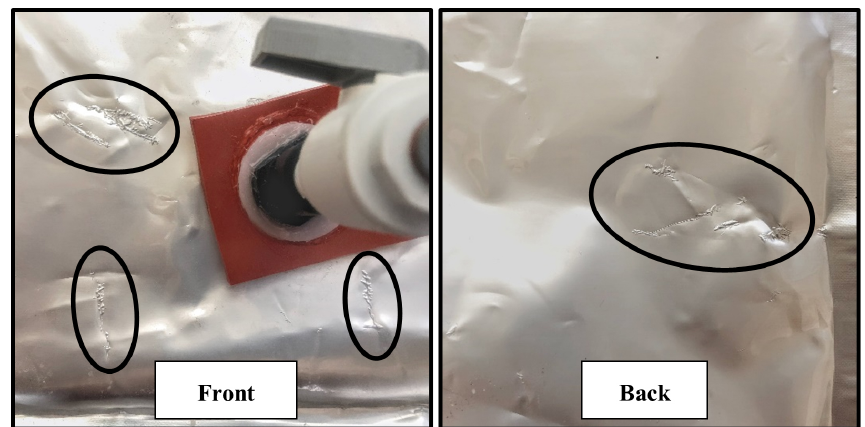
Figure A3. The ovals indicate marks on the exterior of “batch 2, bag 1, lab”. These marks appear to be damage to the interior metallic layer, possibly due to creasing of the bag. These marks were not present on any other bag used in this